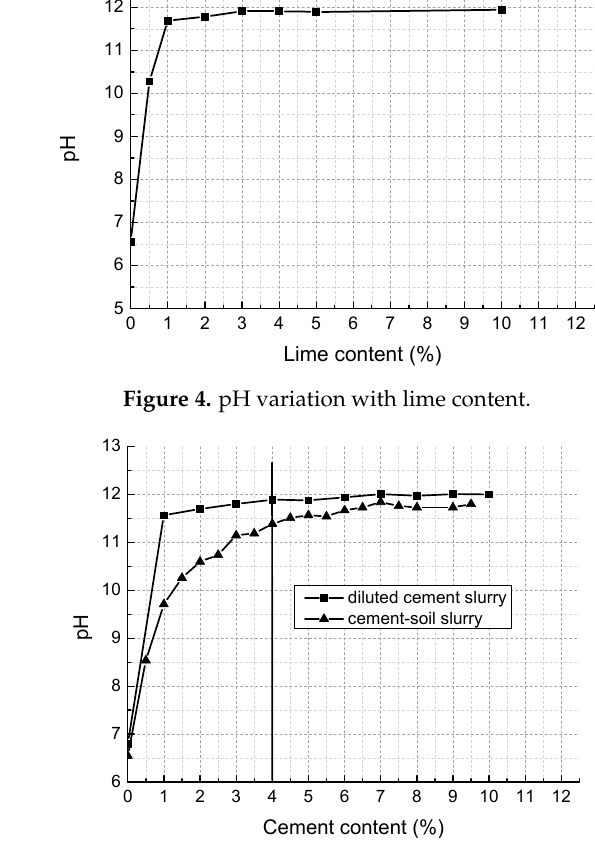
Figure 5. pH variation with cement content.